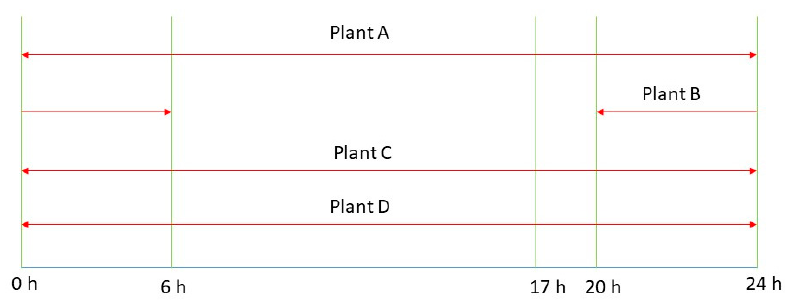
Figure 6. An illustration of time slices identification in the industrial plants.